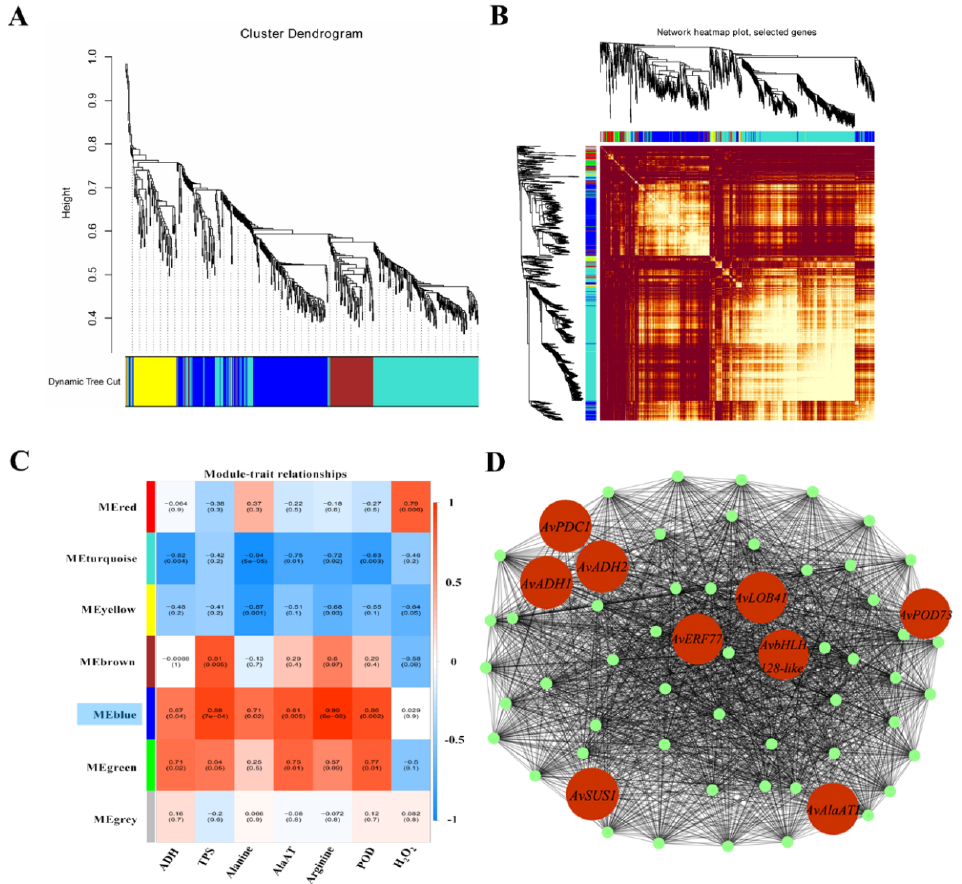
Figure 13. Identification of co-expression network modules. ( A ) cluster dendrogram of genes included in co-expression module analyses; ( B ) similarity of selected genes at the network topology level; ( C ) module-trait associations based on Pearson’s correlation coefficients; ( D ) gene network of the blue module, which was positively correlated with all selected indexes, except H 2 O 2 . Candidate genes within the blue module are highlighted in red and coded for gene descriptors based on annotations.